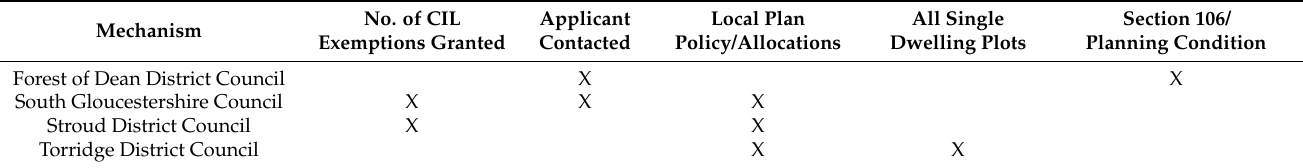
Table 11. Methods used by LPAs who applied multiple mechanisms. Mechanism